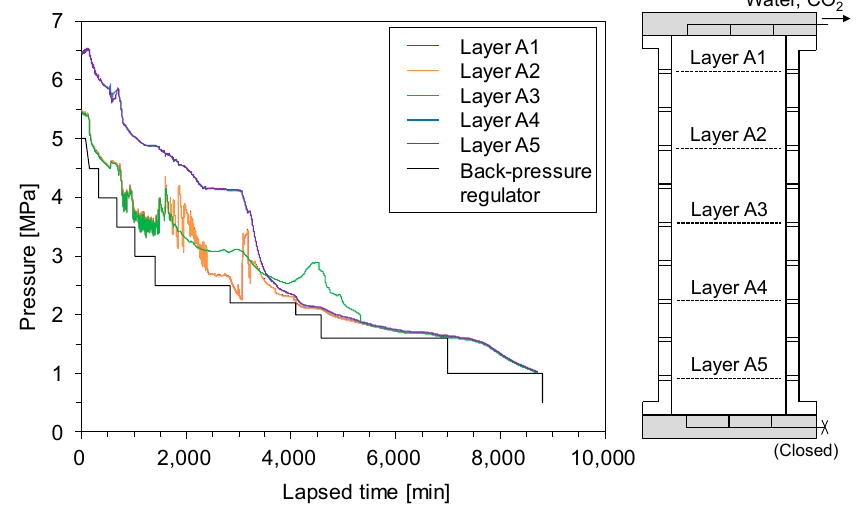
Figure 8. Pressure of the cell with lapsed time during depressurization.